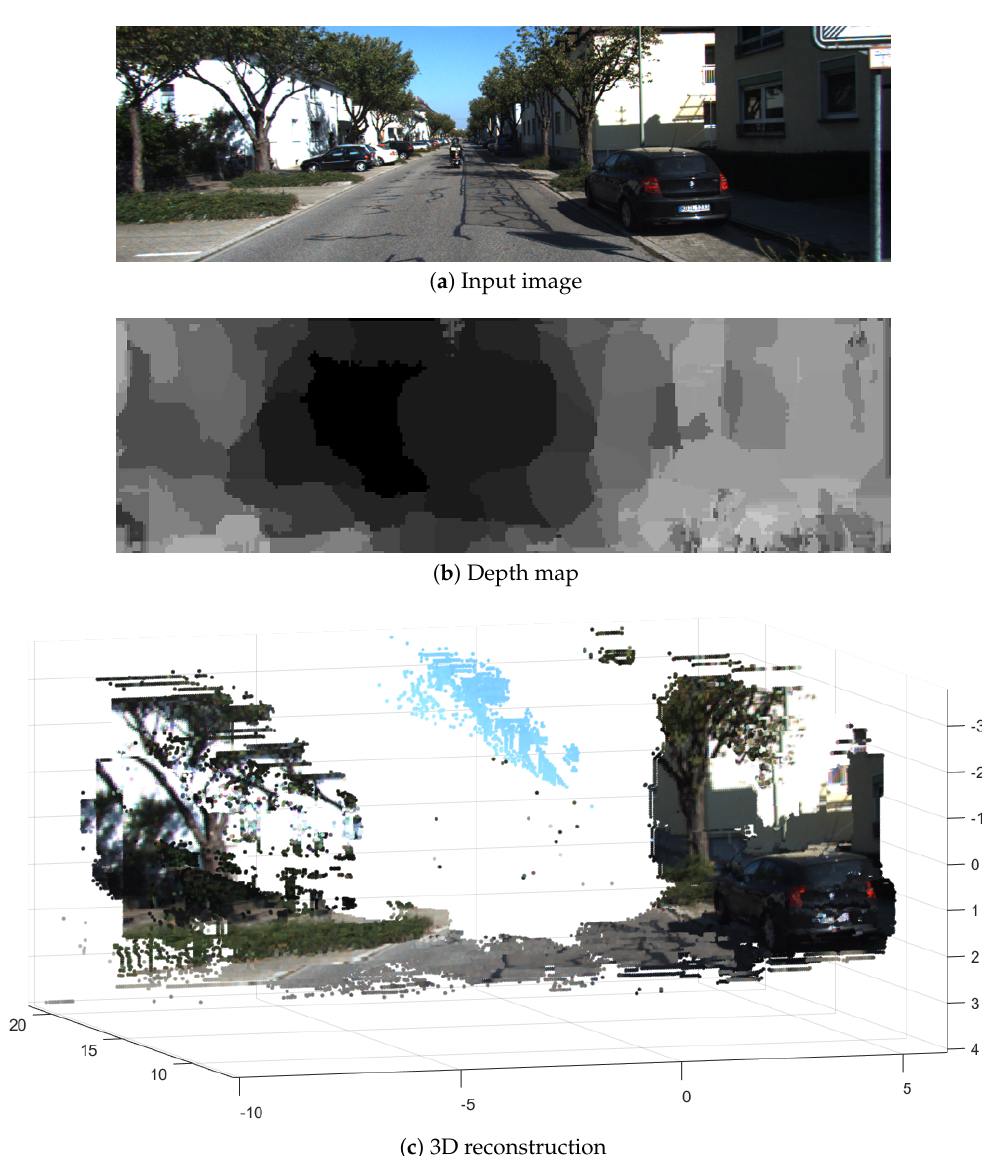
Figure 17. The KITTI dataset: Sequence 00; 3D reconstruction by the proposed approach. Our algorithm provides rough depth maps (a lower accuracy compared with previous algorithms) but with real-time processing and with the capability to be implemented in embedded hardware; as a result, real-time dense 3D reconstructions can be obtained, and these can be exploited by several real world applications such as augmented reality, robot vision and surveillance, and autonomous